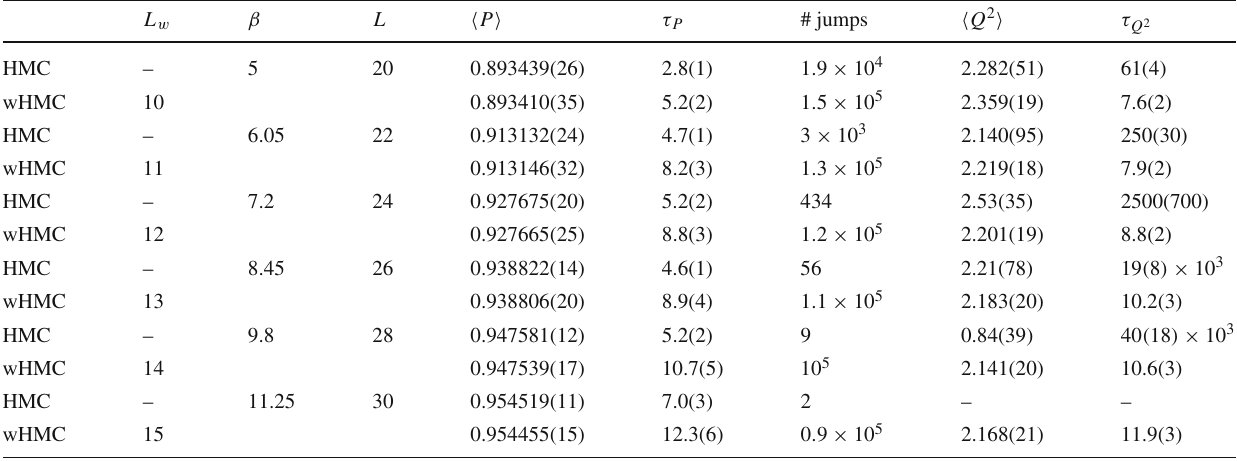
Table 1 Simulation parameters and results for the pure gauge model using N conf = 5 × 10 5 configurations in each case. The column “# jumps” indicates the number of transitions in which the topological